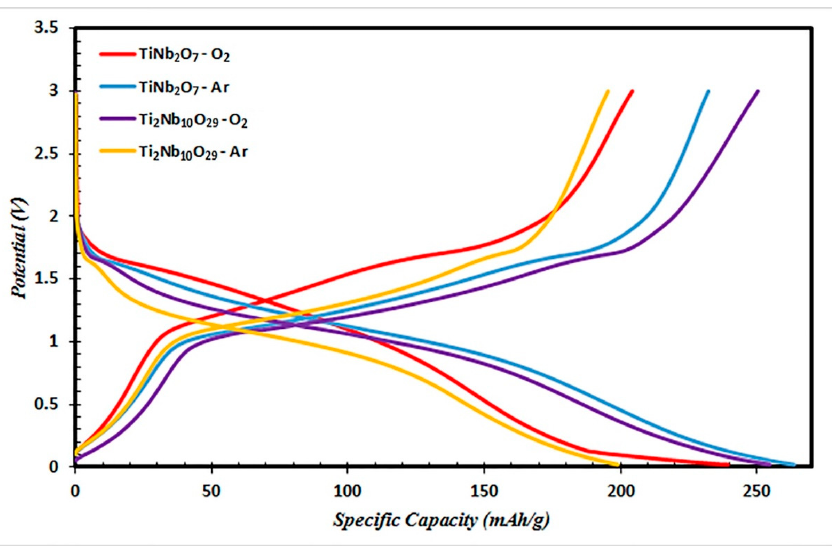
Figure 4. Charge/discharge curves of two synthesized samples in different atmospheres at 0.1 C cycled between 0 and 3 V.